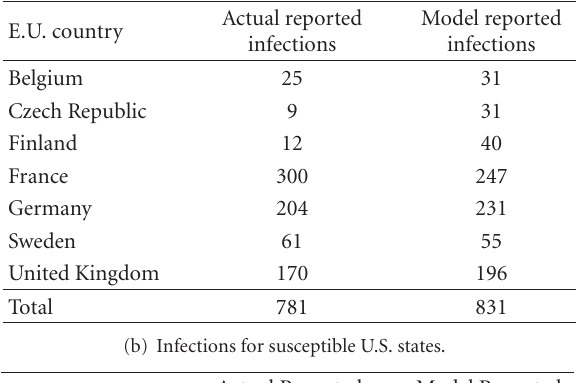
Table 2: Model output and actual reported infections for (a) Europe and (b) the